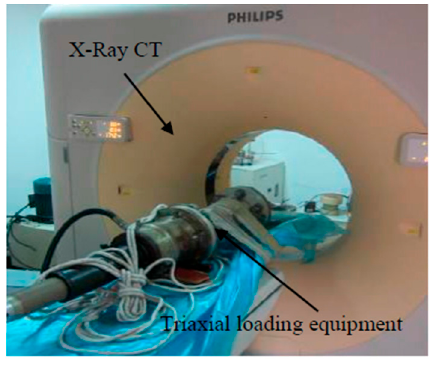
Figure 3. X-ray CT scanner.